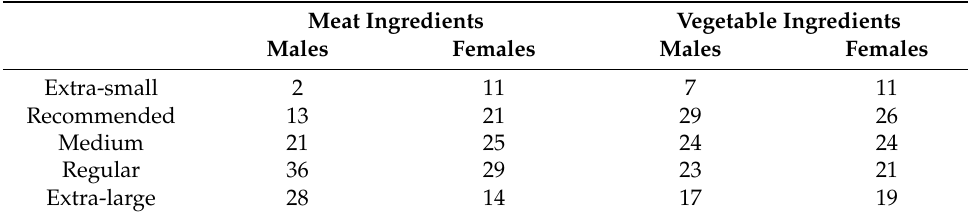
Table 4. Distributions of proportions (%) of the estimated “normal” portion sizes of meat and vegetable ingredients for males and